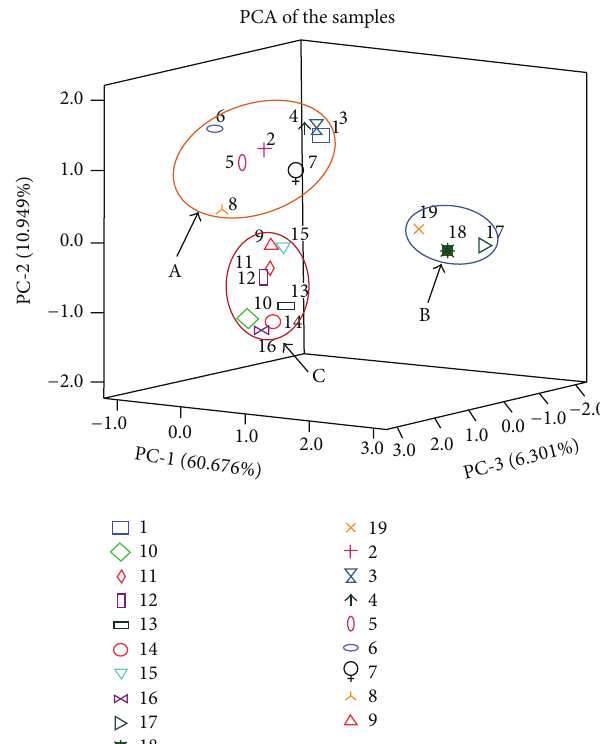
Figure 3: The PCA of the Thais clavigera Samples 1–19 are collected from Yingkou, Liaoning; Dalian (Dachangshan Island), Liaoning; Dalian (Clam Island), Liaoning; Yantai, Shandong; Weihai, Shan- dong; Qingdao, Shandong; Lianyungang (Lian Island), Jiangsu; Lianyungan (Qinshan Island), Jiangsu; Wenzhou (Nanfu Island), Zhejiang; Wenzhou, Zhejiang; Ningbo (Meishan Island), Zhejiang; Ningbo (Yushan Island), Zhejiang; Fuzhou (Langqi Island), Fujian; Fuzhou (Dongjia Island), Fujian; Xiamen (Dadeng Island), Fujian; Xiamen (Gulangyu Island), Fujian; Sanya (Sanya Bay), Hainan; Sanya (Wuzhizhou Island), Hainan and Haikou,